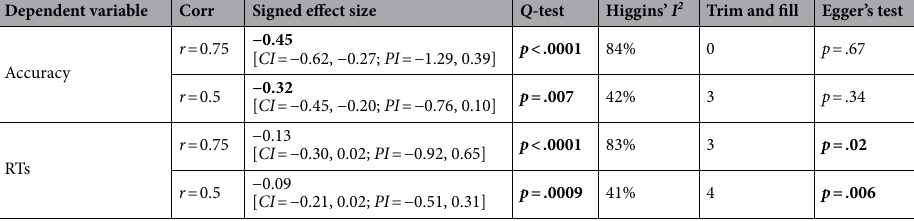
Table 6. Results of the meta-analyses performed on signed effect sizes with the effect sizes of the within- participants studies included computed using r = 0.75 or r =